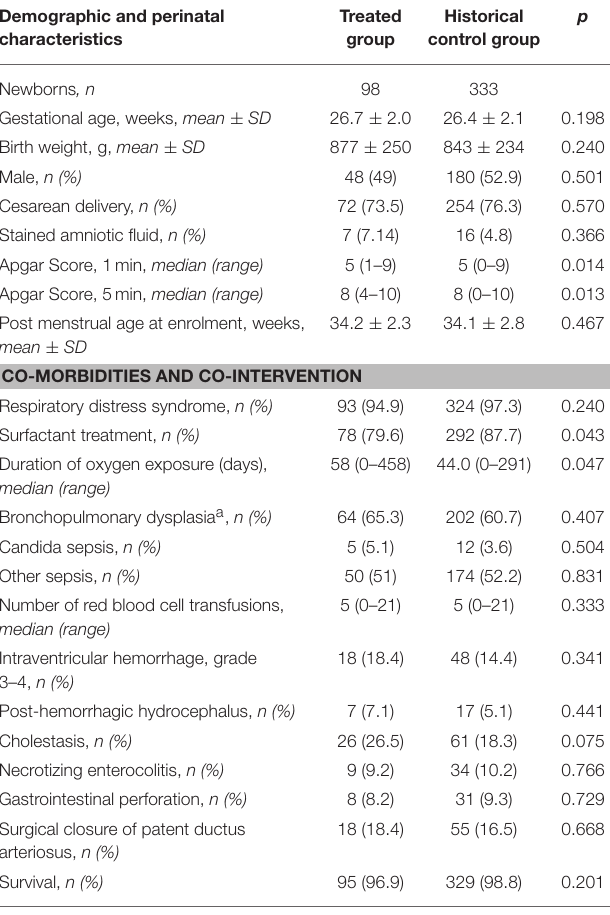
TABLE 1 | Demographic, perinatal characteristics, co-morbidities, and co-interventions of treated and historical